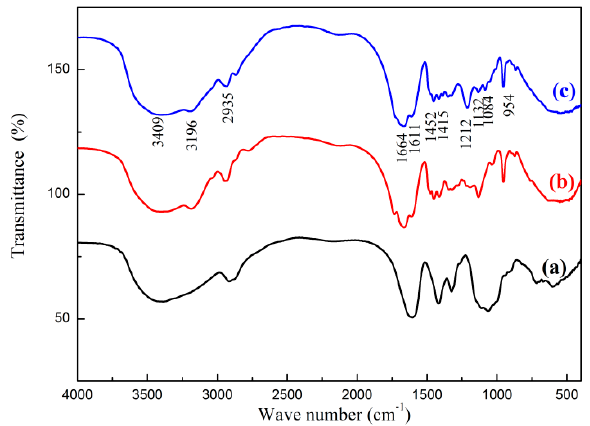
Figure 2. FTIR spectra of ( a ) CMCS, ( b ) P(AM-DMC), and ( c ) CCPAD.